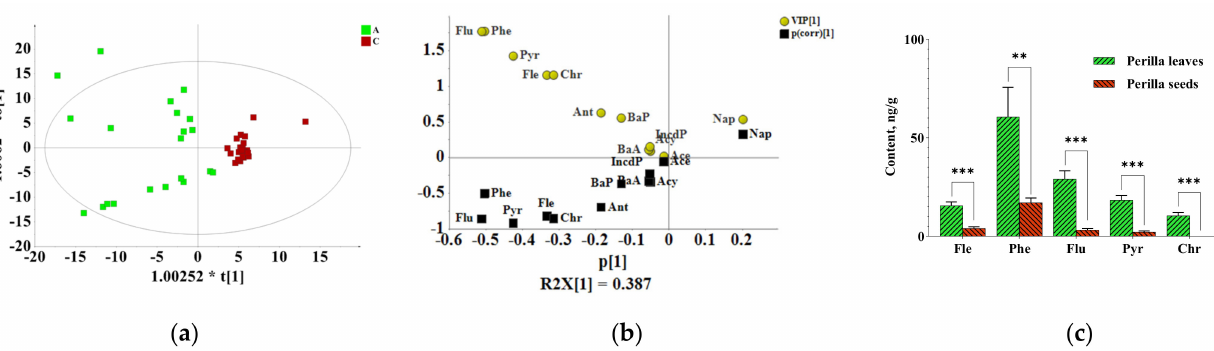
Figure 4. The difference between perilla leaves (A) and seeds (C). ( a ) OPLS-DA score plot; ( b ) (V + S)- plot of OPLS-DA. ( c ) The contents of differential compounds ( C , ng/g) (**: p ≤ 0.01; ***: p ≤